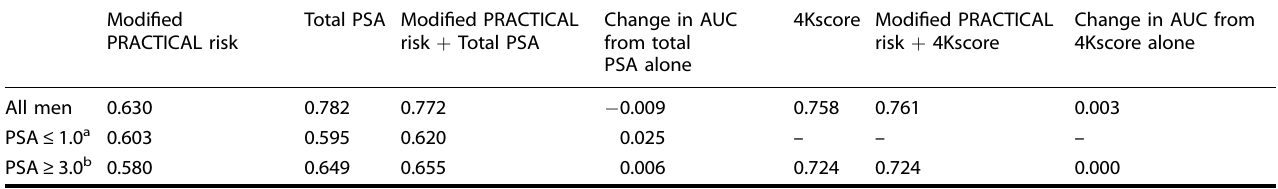
Table 7. Discrimination for three risk markers measured at baseline and change in discrimination when adding Modi fi ed PRACTICAL risk to total PSA and the 4kKscore for the outcome of prostate cancer metastasis or